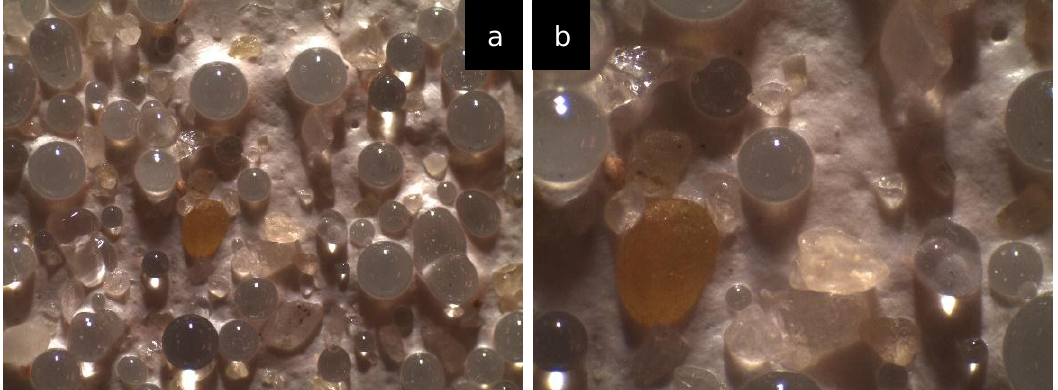
Figure 11. Microscope detail of S9 sample: ( a ) ×16 magnifications; ( b ) ×35 magnifications.